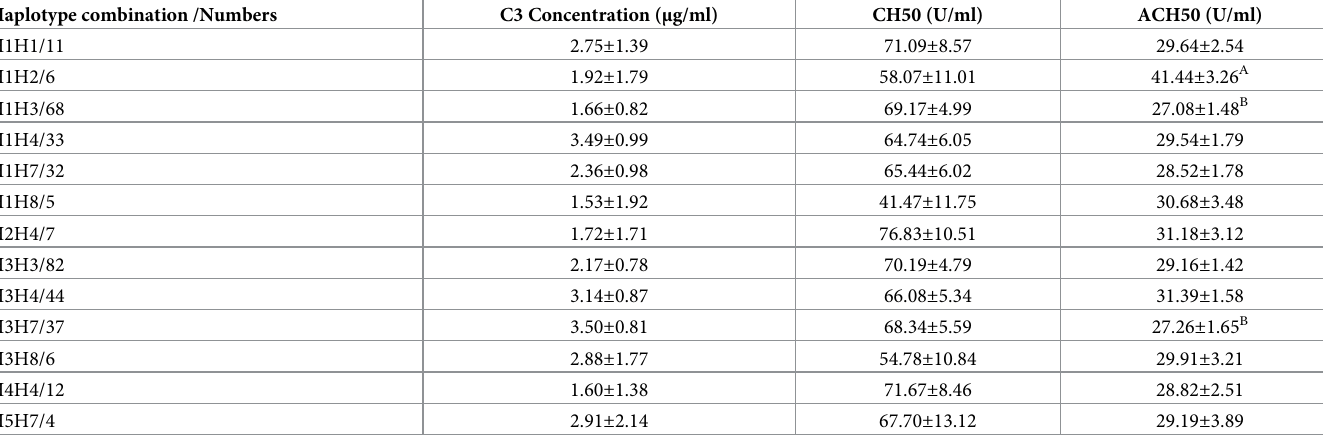
Table 9. Least squares mean (LSM) + standard error (SE) of C3 concentration, ACH50 and CH50 values in different haplotypic combinations among 354 Chinese Holstein